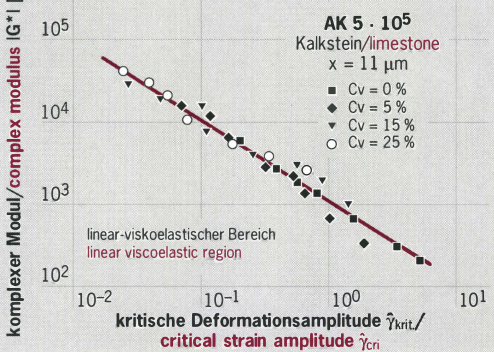
Fig. 8: Complex modul as a function of critical strain amplitude for silicone oil AK5. 105